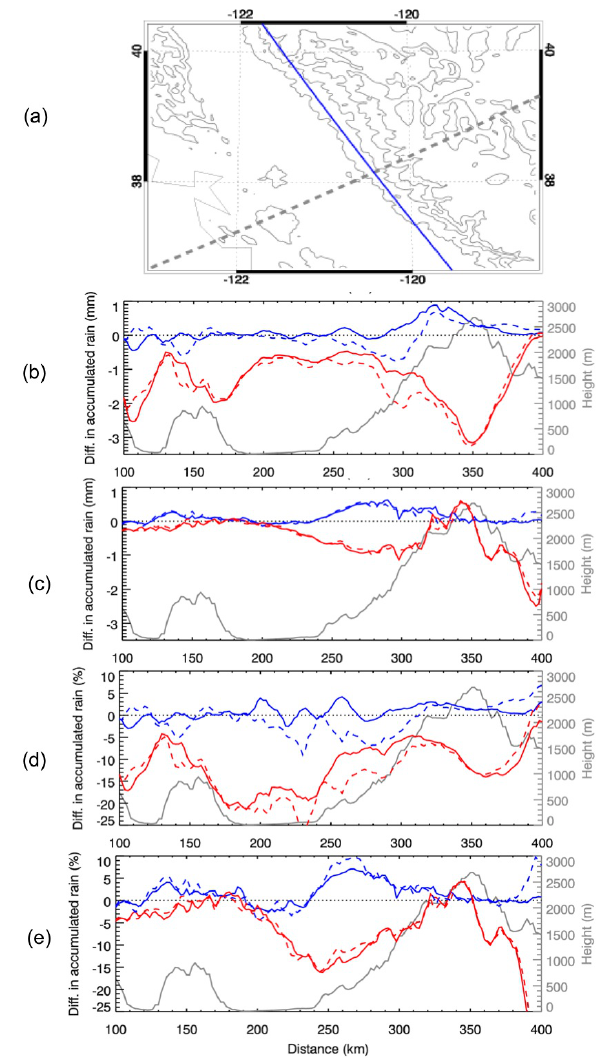
Fig. 11. Differences of the accumulated precipitation averaged over the grid points along a strip one grid cell wide and par- allel to the blue line in the (a) along the cross section (i.e., the dashed gray line in (a) ) for (b) FEB16 and (c) MAR02. (d) and (e) are the corresponding percentage changes. The blue lines denote the CCN effects under the conditions of dust (solid; HiCCN&Dust – LoCCN&Dust) and no dust (dashed; HiCCN&NoDust – LoCCN&NoDust), and the red lines denote dust effects by removing the dust layer under the low CCN (solid; LoCCN&NoDust – LoCCN&Dust) and high CCN (dashed; HiCCN&NoDust – HiCCN&Dust)